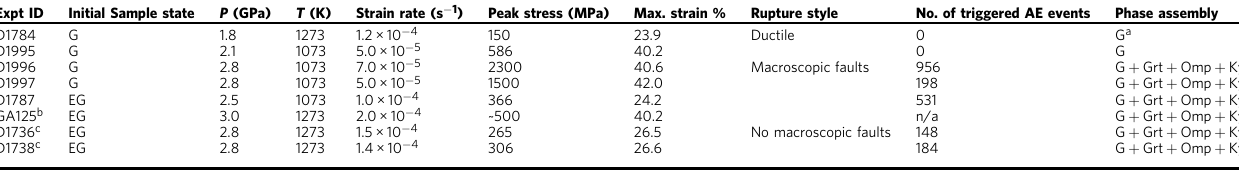
Table 1 Experimental conditions, mechanical behavior, and AE